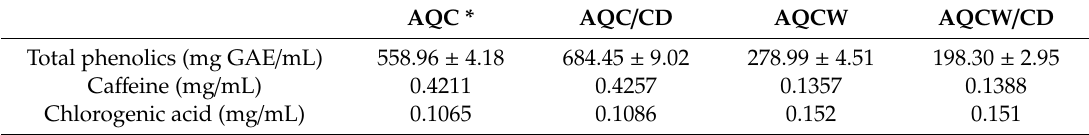
Table 6. Total phenolics, ca ff eine, and chlorogenic acid content in the di ff erent brews. AQC * AQC / CD AQCW AQCW / CD Total phenolics (mg GAE / mL) 558.96 ± 4.18 684.45 ± 9.02 278.99 ± 4.51 198.30 ± 2.95 Ca ff eine (mg / mL) 0.4211 0.4257 0.1357 0.1388 Chlorogenic acid (mg / mL) 0.1065 0.1086 0.152